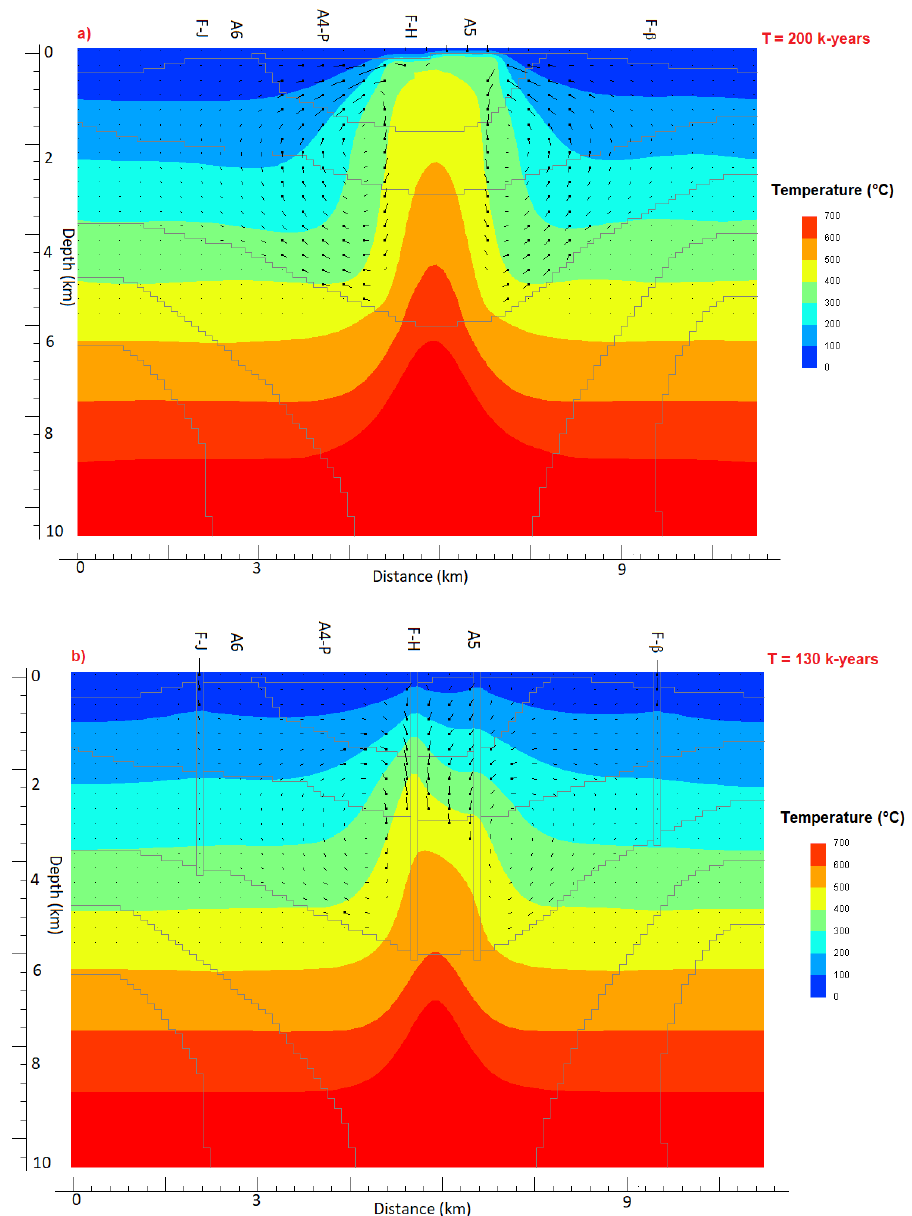
Figure 7. Simulated temperature and flow vectors for ( a ) scenario 7 at time 200,000 years and ( b ) scenario 8 at time 130,000 years. The direction of flow is from the point to the end of straight lines. The length of each line indicates the water vector magnitude, where 1.2 km = 10 −6 g s −1 cm −2 . Measured temperatures in geothermal wells A6 and A4 best match with the simulated temperatures at the locations of the wells for scenarios 5A, 5B, 6A and 6B